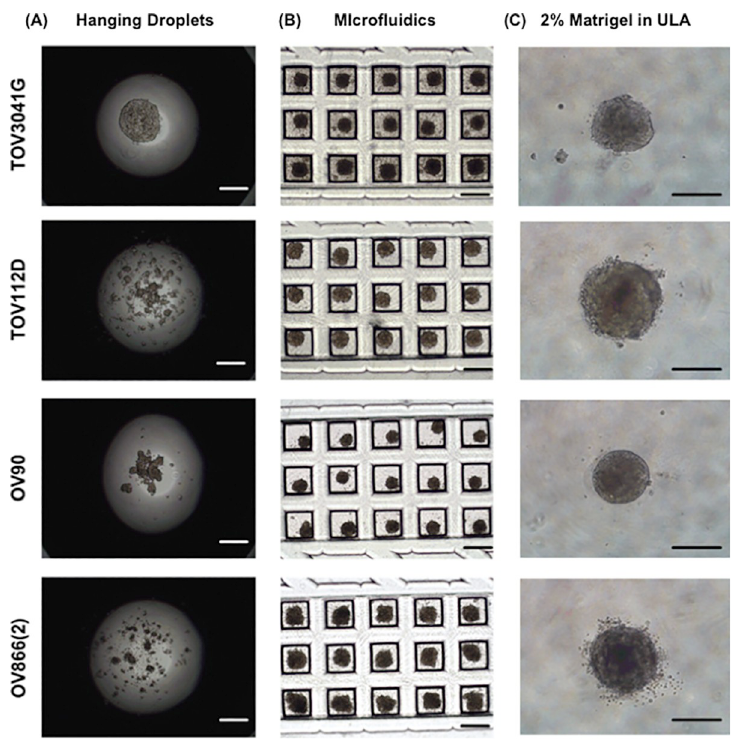
Fig 3. Capacity of EOC cell lines to form spheroids in three different culture conditions. Representative microscopic bright field images of TOV3041G, TOV112D, OV90 and OV866(2) cells cultured 48 hours in hanging droplets (A), within the custom PDMS-based microfluidic chips, (B) and in 96-well round-bottom ULA plates with 2% Matrigel (C). The scale bar is 500 μ m.